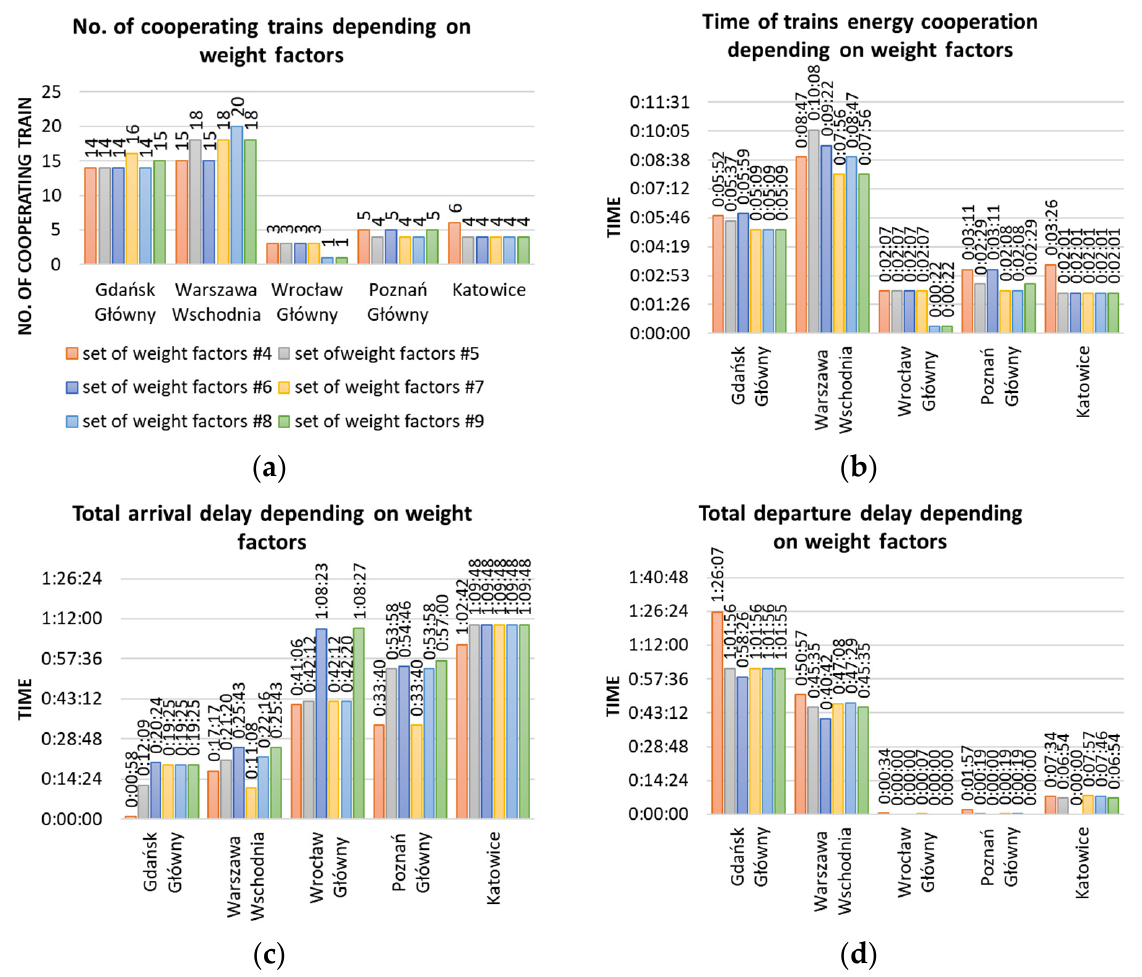
Figure 7. Summary of the results of the individual component functions of multi-criteria optimiza- tion (24) according to the adopted weight factors 4–9. ( a ) No. of cooperating train depending on weight factors. ( b ) Time of trains energy cooperation depending on weight factors. ( c ) Total ar- rival delay depending on weight factors. ( d ) Total departure delay depending on weight factors. Source: own